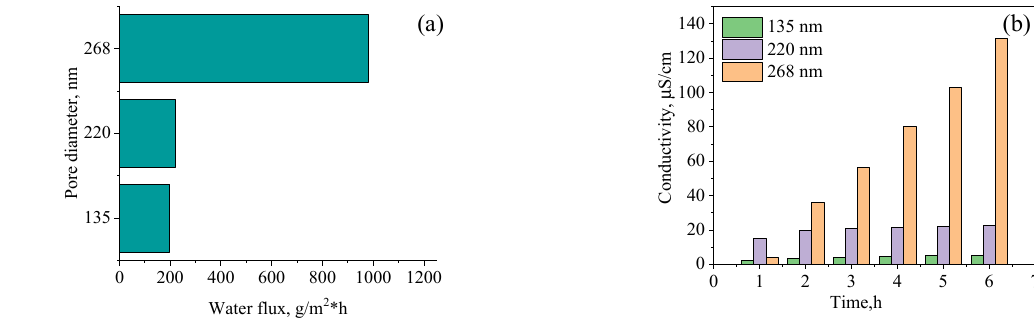
Figure 9. Water flux ( a ) and electrical conductivity ( b ) during continuous DCMD tests using hydrophobized PET TeMs-g-PS with different pores for radioactive waste solution. Adapted from [179].